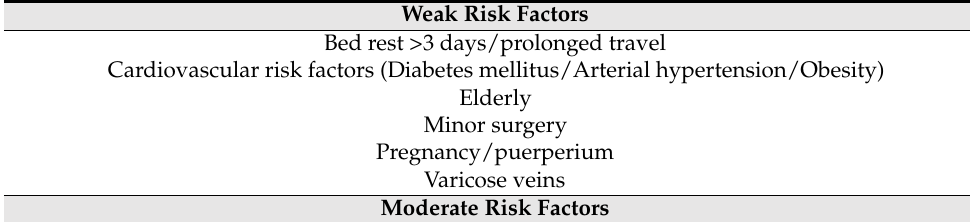
Table 2. Risk factors for venous